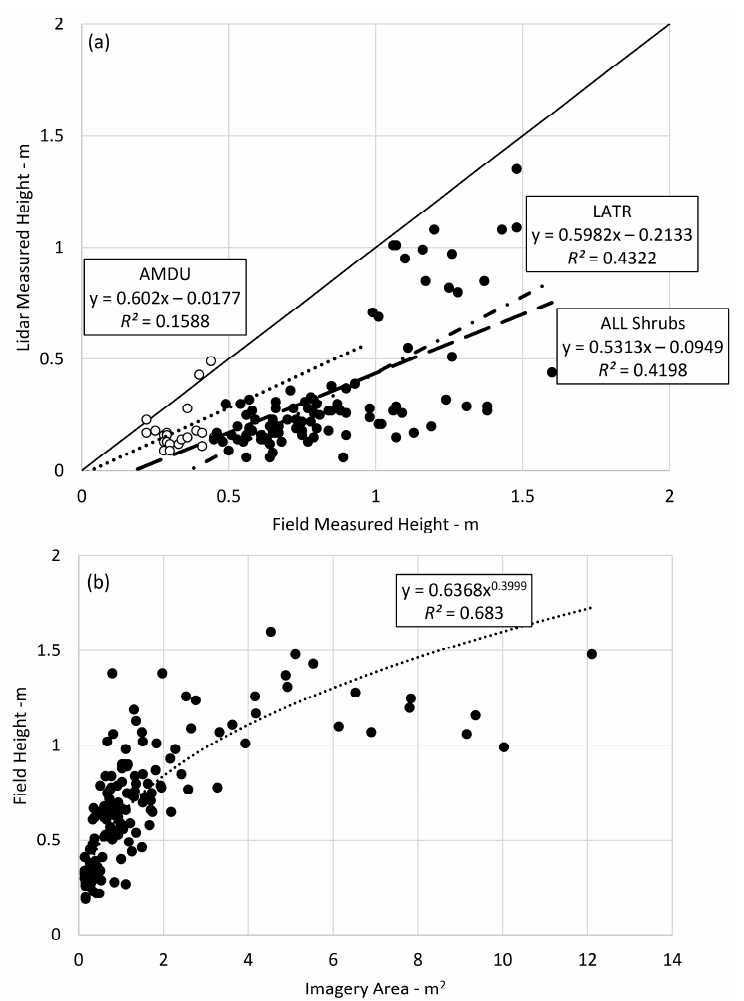
Figure 7. ( a ) Comparison between field-measured and LiDAR-measured heights of LATR and AMDU shrubs; ( b ) field-measured height as a function of imagery-derived area for all shrubs. In ( a ), the solid line is the 1:1 line; the dashed/dotted line is for LATR, the dotted line is for AMDU, and the long-dashed line is for all